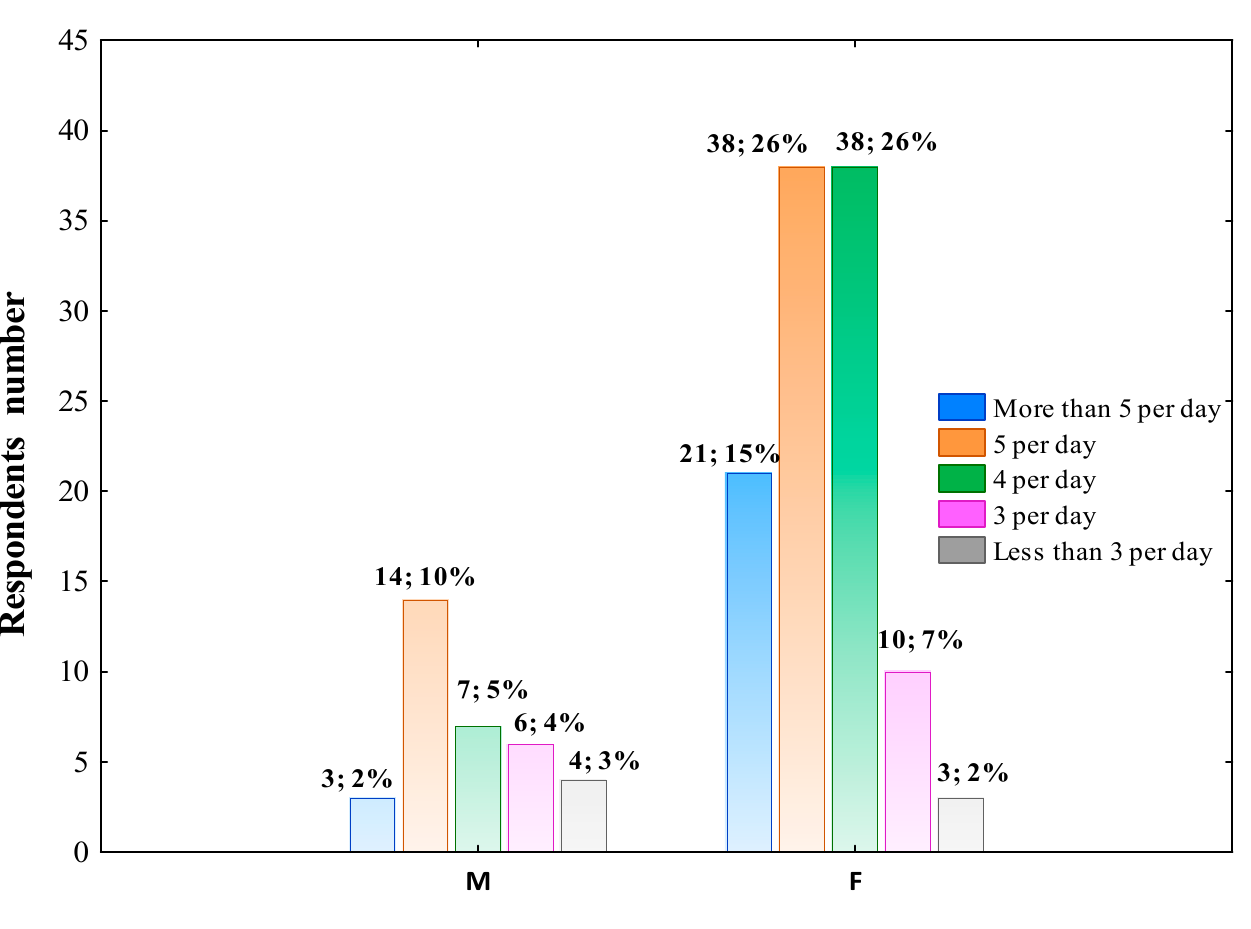
Figure 3. Meals consumption during the COVID-19 pandemic per day across gender groups (M–men; F–female). The column description includes the respondents’ number in this gender who chose such an answer, followed by the percentage of the total respondents. Data were analyzed using Pearson’s chi-squared test. Pearson’s χ 2 = 9.653; df = 4; p = 0.0466; n = 145.